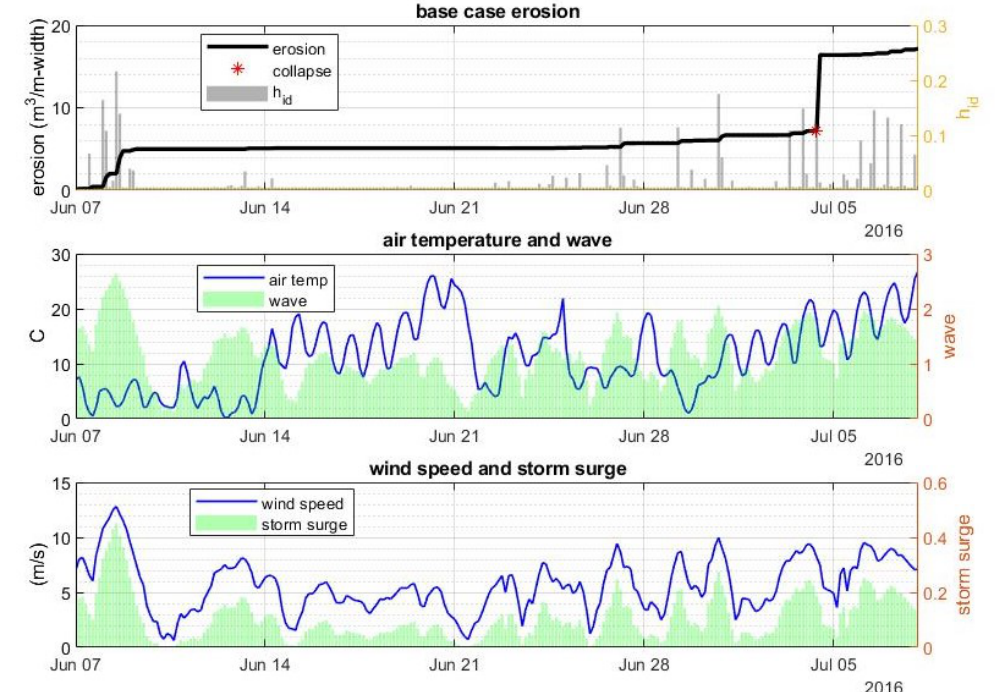
Figure A10. Erosion of the base